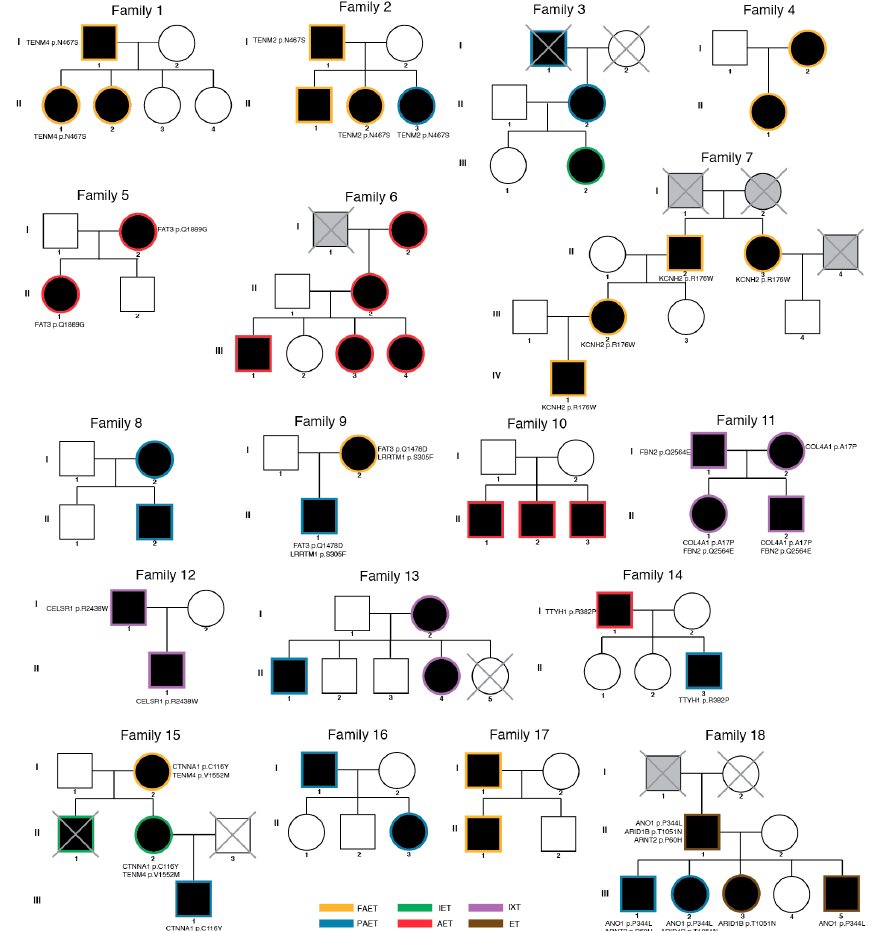
Figure 2. Pedigree information with risk variants. Eighteen families with strabismus are described. Of 98 participants, 87 individuals were analyzed. Participants excluded from the analysis were marked with X. Affected family members are labelled with the black circle (female) and square (male). Unaffected individuals were labelled without the filled color. Individuals with unknown diagnostic status were labelled with grey color. Risk variants are described with their affected gene and amino acid change. All variants are heterozygous. (FAET; Fully accommodative esotropia, PAET; Partially accommodative esotropia, IXT; Intermittent exotropia, ET; Esotropia (unspecified), AET; Acquired esotropia, IET; Infantile esotropia).